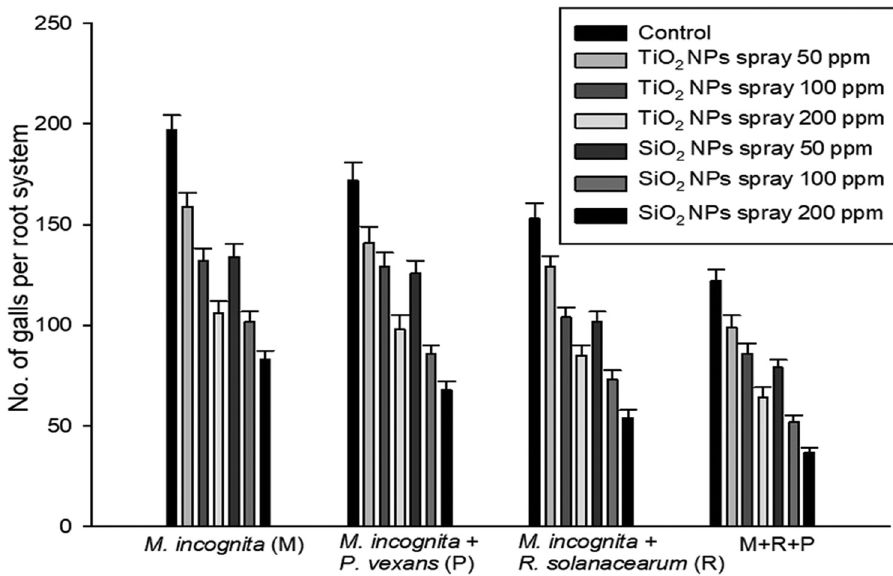
Figure 4: E ff ect of SiO 2 - NPs and TiO 2 - NPs on root galling of M. incognita ( M ) inoculated alone ( M ) and in combination with P. vexans ( P ) and R. solanacearum ( R ) . Error charts re fl ect the standard